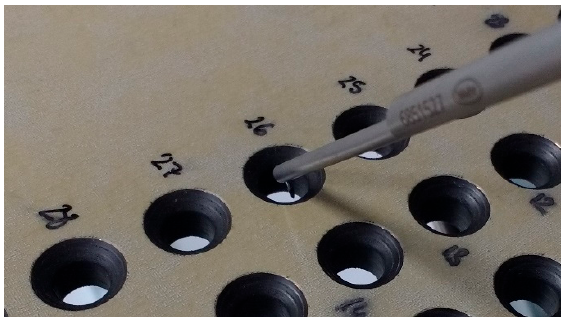
Figure 2. Hole profile and roughness analysis of a carbon fiber reinforced plastics (CFRP) coupon with a contact